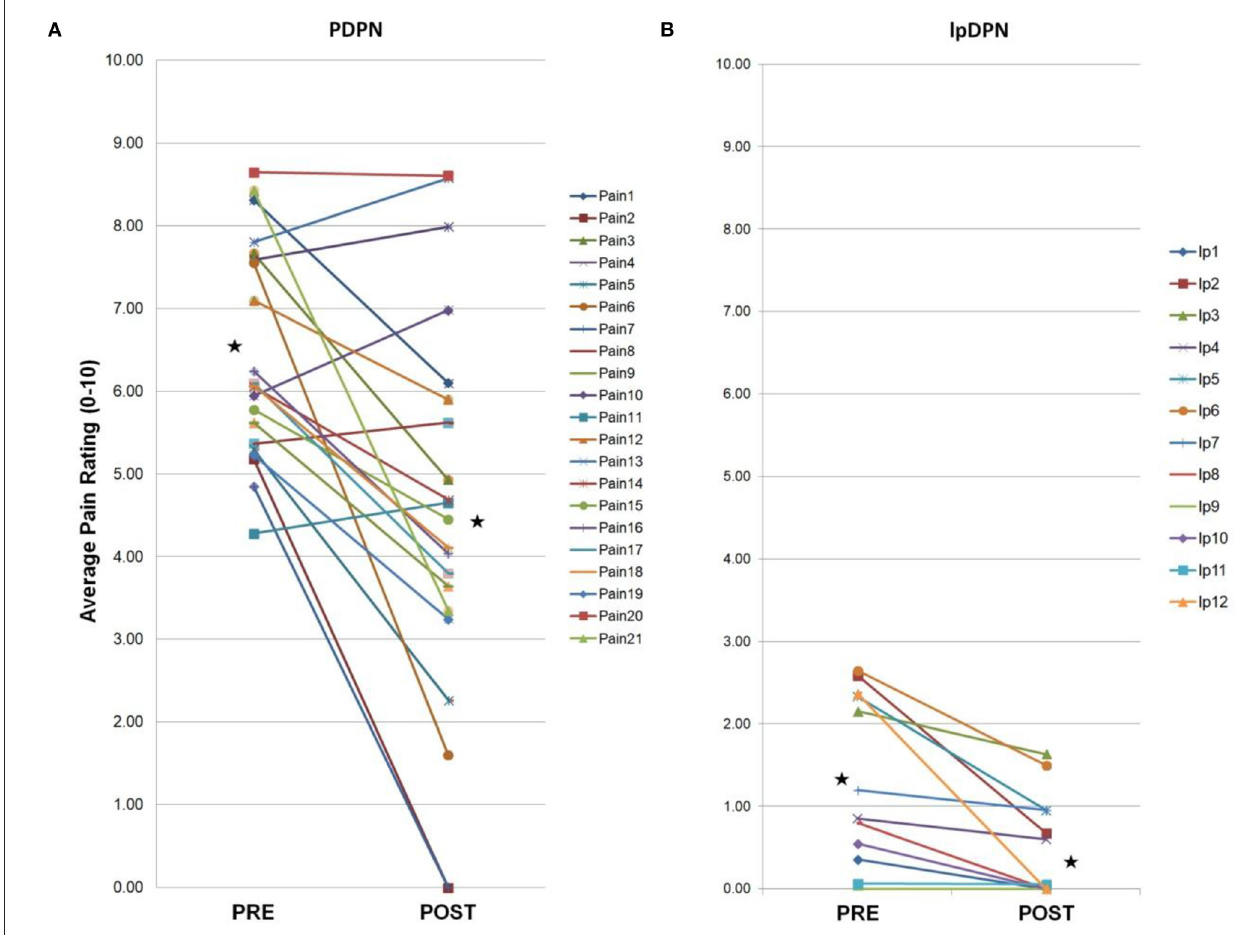
FIGURE 1 | Individual composite pain scores. A 4-week topical 5% lidocaine treatment resulted in a significant reduction in average pain scores for the PDPN and lpDPN cohorts. Pre-treatment (PRE) and post-treatment (POST) composite pain scores are shown for (A) the PDPN (Pain 1–Pain 21) and (B) the lpDPN (lp1-lp12) patient cohorts. Black stars represent the group average values with significant differences ( p ≤ 0.05 by